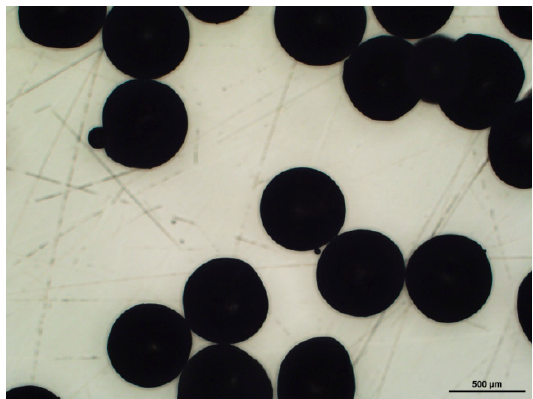
Figure 9. Optical micrograph of paraffin beads having an average particle diameter of 450 µm, and obtained between sieves of mesh sizes 400–500 µm. The scale bar represents 500 µm.